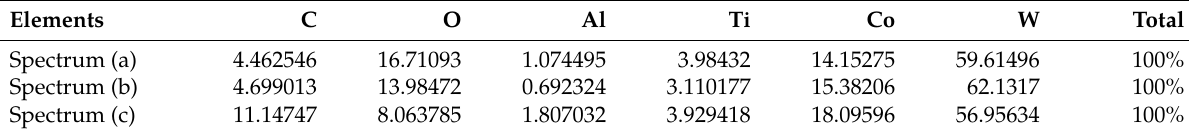
Table 5: Different elements of the spectra (a – c) SEM/EDS in different points of the used track for temperature P1(450°C). Elements C O Al